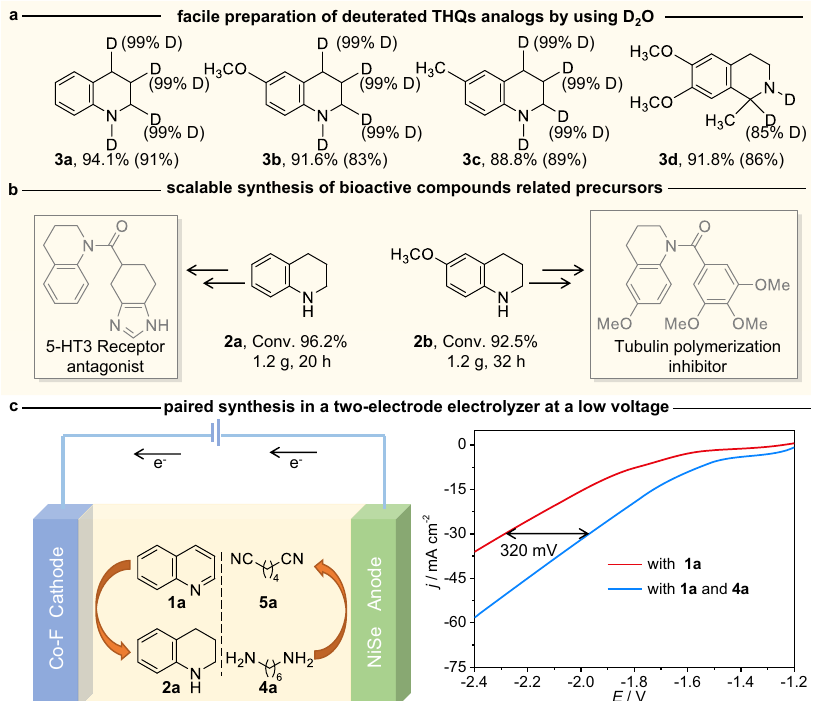
Fig. 5 | The applications of the methodology. a Facile preparation of deuterated analogs of THQs by using D 2 O over the Co-F cathode. Reaction conditions: sub- strates (0.2mmol, 28.57mmolL − 1 ),Co-F electrode (working area:1.0cm 2 ), a mixed solutionof0.5MK 2 CO 3 (D 2 O)/dioxane(6:1v/v,7mL), − 1.1V,RT,16h. b Gram-scale